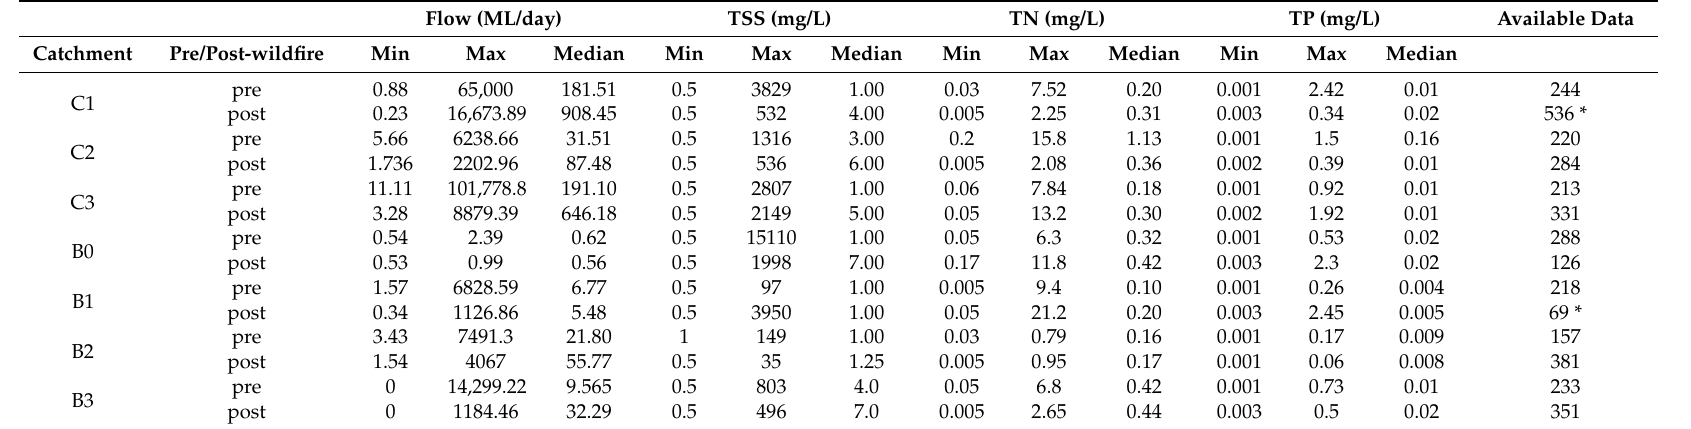
Table 3. Summary of flow and WQ